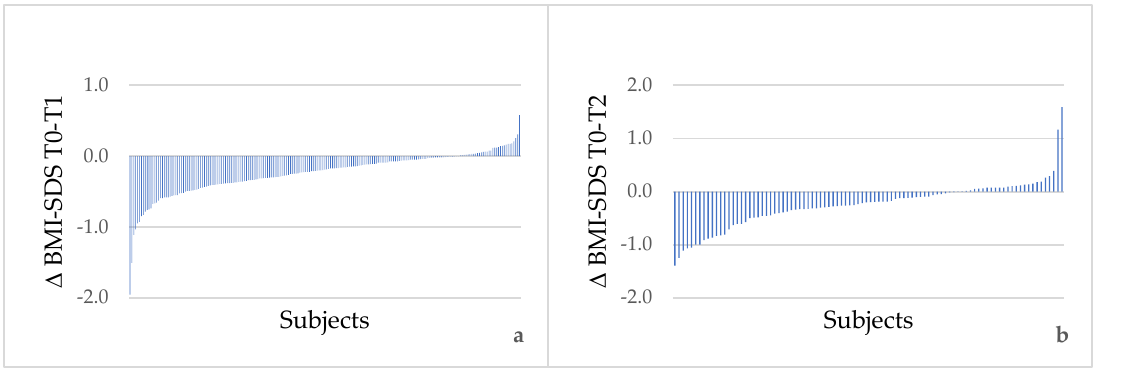
Figure 1. BMI-SDS changes between T0 and T1 for each patient who attended the Center at 6 ± 3 months ( a ) and at 12 ± 3 months; ( b ) after the first visit.